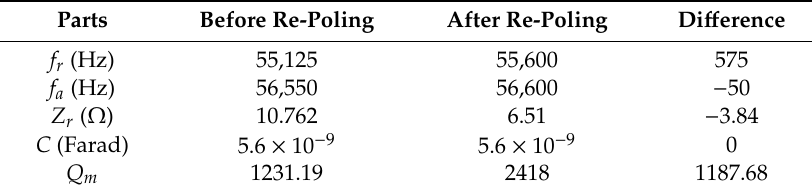
Table 2. Changed values before and after re-poling.